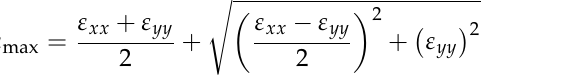
Figure 4. Stress ‒ strain analysis of mortar